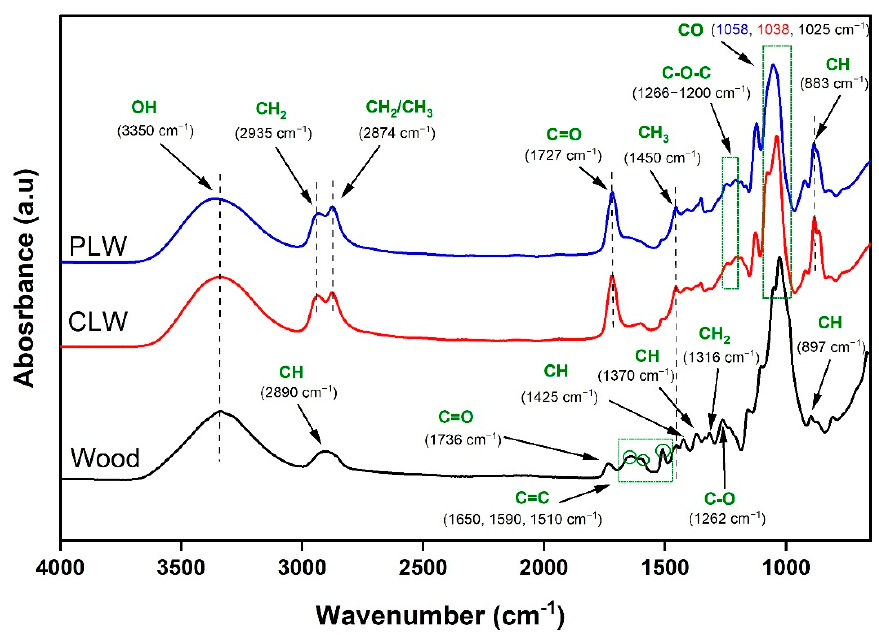
Figure 2. Fourier transform infrared spectroscopy (FTIR) spectra of spruce wood sawdust, crude liquefied wood (CLW) and purified liquefied wood (PLW).